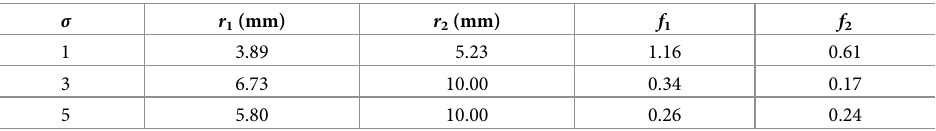
Optimal one-step profile for one fraction of radiation with logistic growth and exponential death. σ is the standard deviation of the initial Gaussian tumour cell density, which starts with 10 7 total cells. r 1 , r 2 , f 1 , and f 2 are the radii and strengths of the steps in the cytotoxic radiation profiles. N ( t + dt ) is the final tumour cell number at the end of radiation.